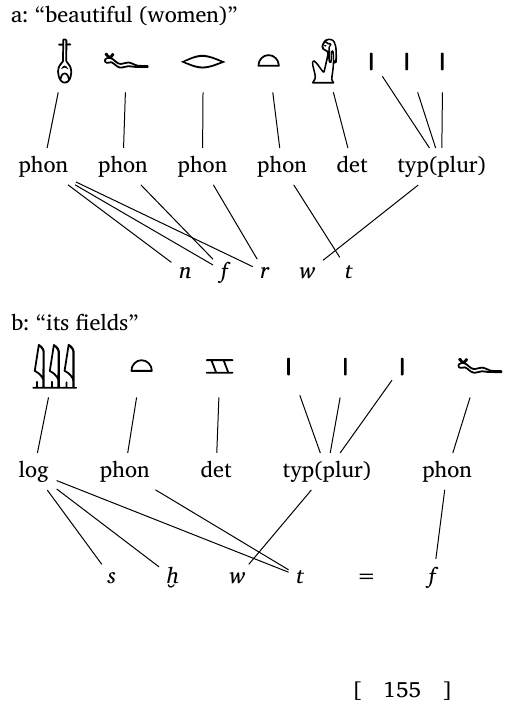
Figure 8: Annotations of feminine plural